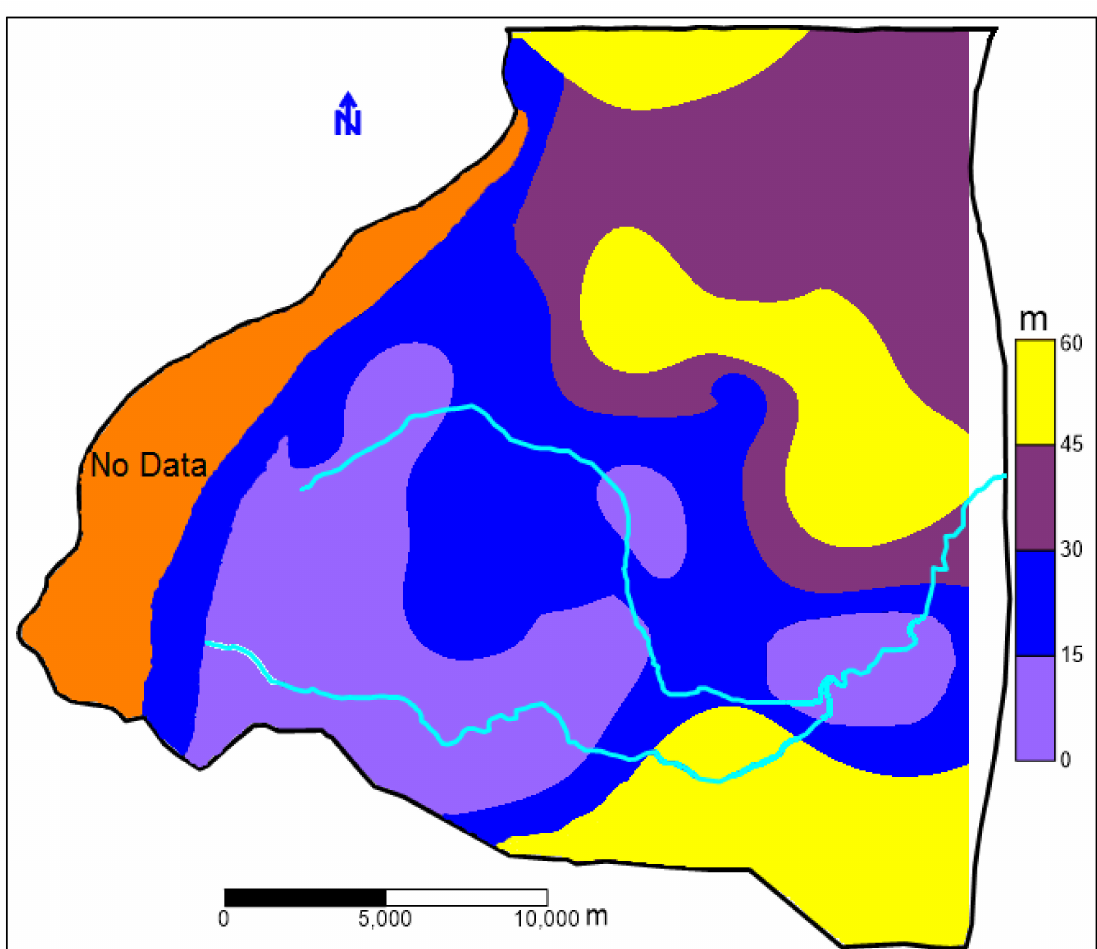
Figure 9. Spatial distribution of depth to groundwater level during October 2006 in the study